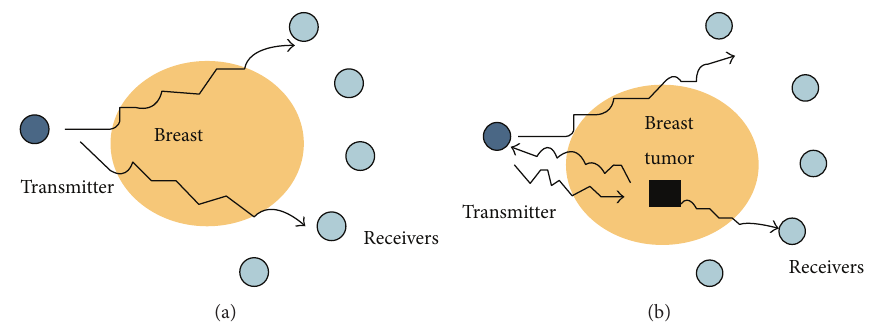
Figure 1: Signal transmission of breast cancer detection.